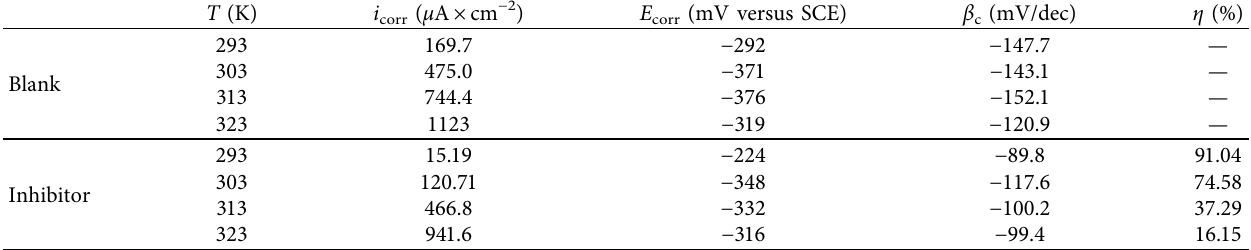
Table 5: Polarization measurements for SS without and with ACM (10 − 3 M) for different temperatures.